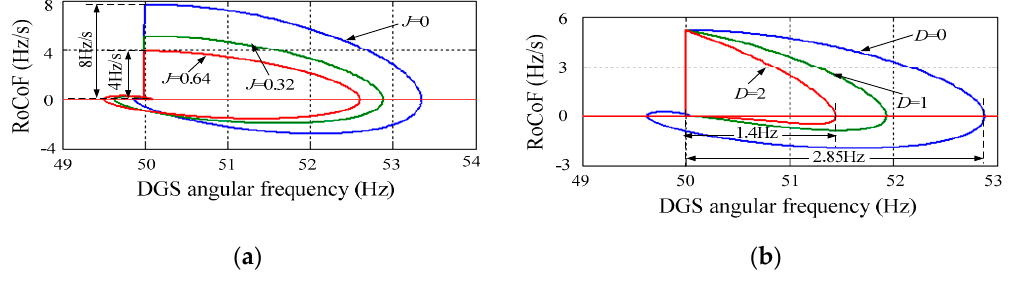
Figure 6. Angular frequency-acceleration curves of DGS with ( a ) virtual inertia control loop; ( b ) virtual damping control loop.